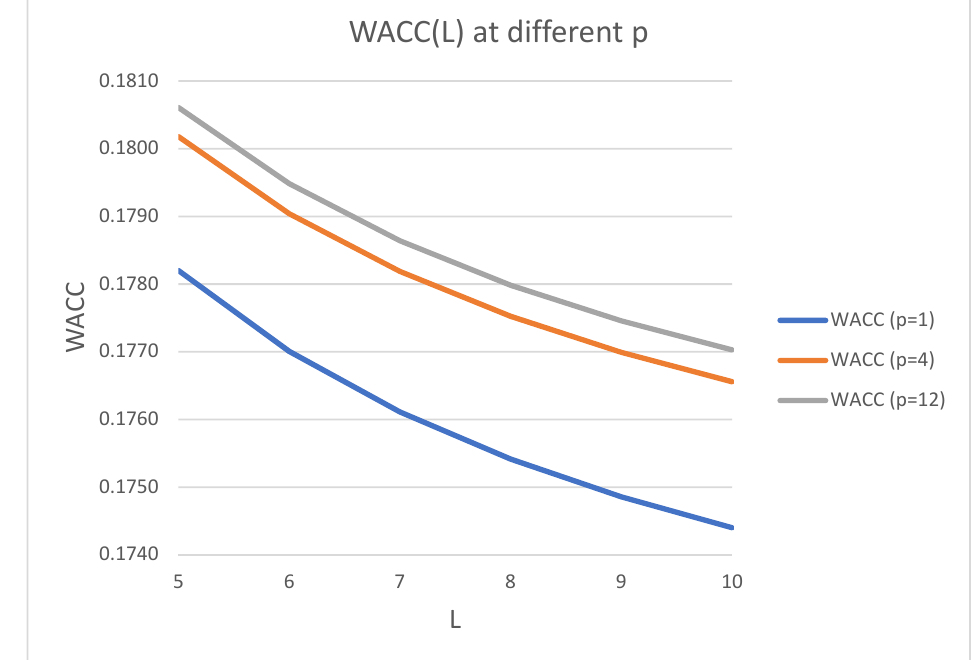
Figure 3. Change of weighted average cost of capital, WACC, with leverage, L , for k d = 0.14, k 0 = 0.22, and p = 1, 4, and 12 (larger scale).